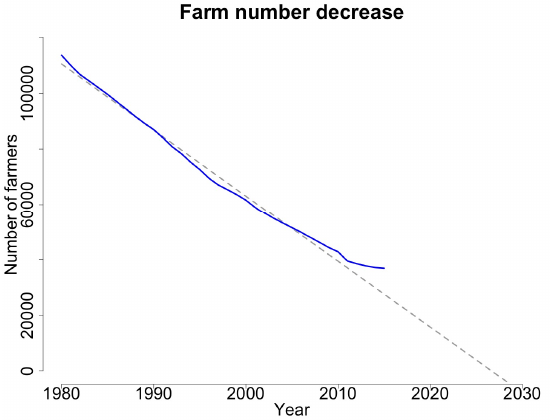
Figure 4. Evolution of the number of farmers in Belgium between 1980 and 2015 and a linear extrapolation of the trend.